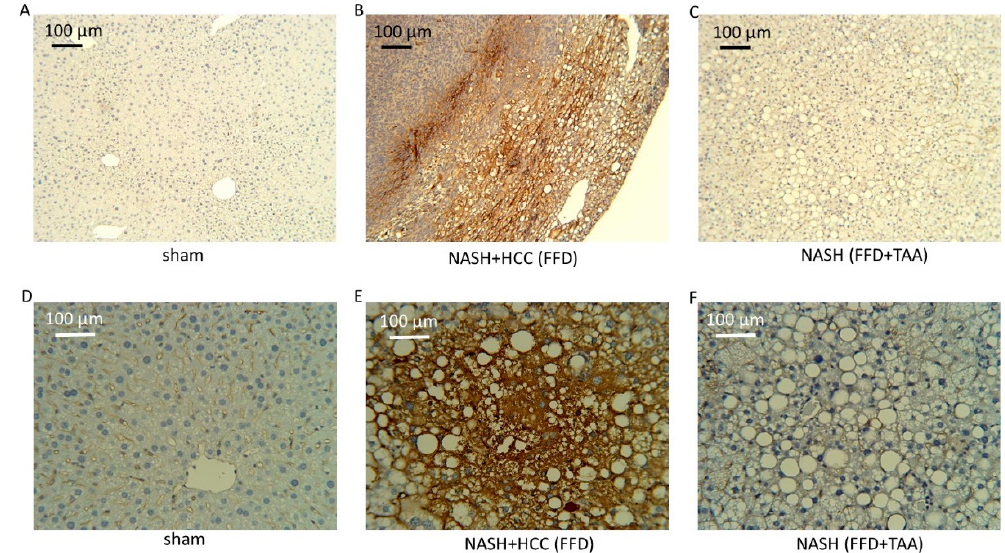
Figure 5. HCC. ( A – C ) Representative liver sections (10×) from Ca-19-9-stained sham, FFD and FFD+TAA groups. Staining is enriched in the FFD liver indicative of HCC. This liver bore a large tumor at sacrifice. ( D – F ) Representative liver sections (25×) from cytokeratin-7-stained sham, FFD and FFD+TAA groups. Staining is enriched in the FFD liver, indicative of HCC. This liver bore several tumors at sacrifice.